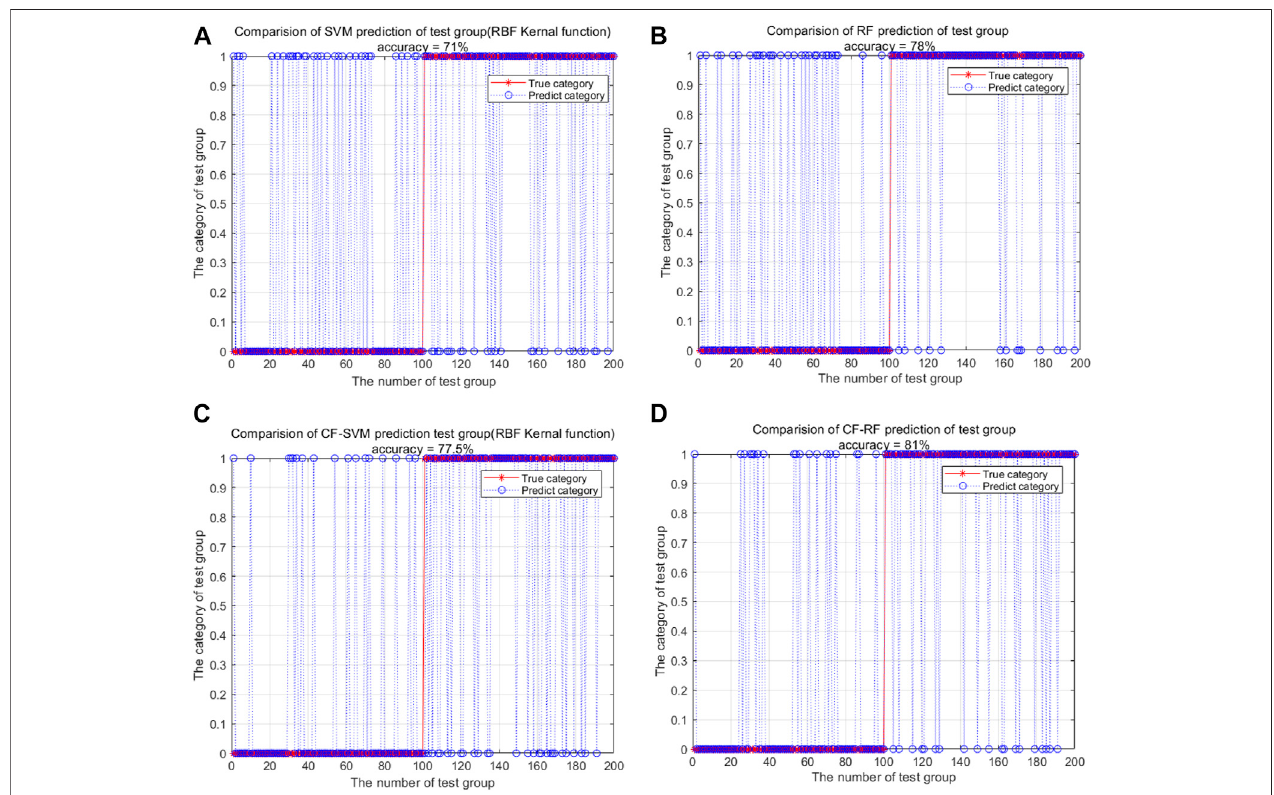
FIGURE 5 | The test results from the: (A) SVM model, (B) RF model, (C) CF-SVM model and (D) CF-RF model.